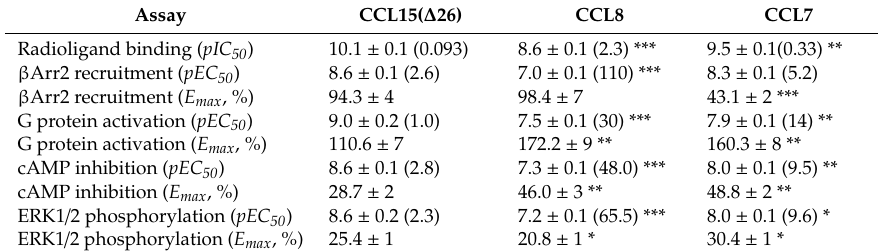
Table 1. A ffi nity, potency, and e ffi cacy of three wild type chemokines at CCR1 1 .